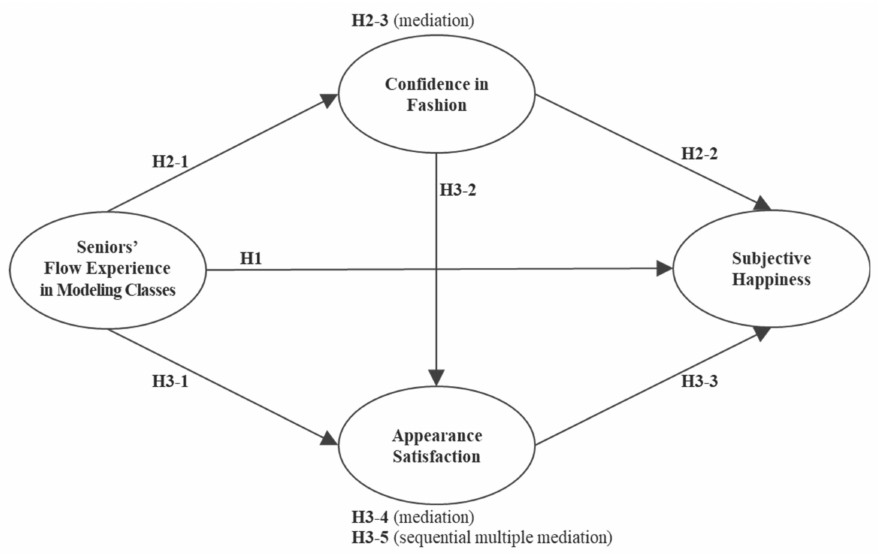
Figure 1. Conceptual model and